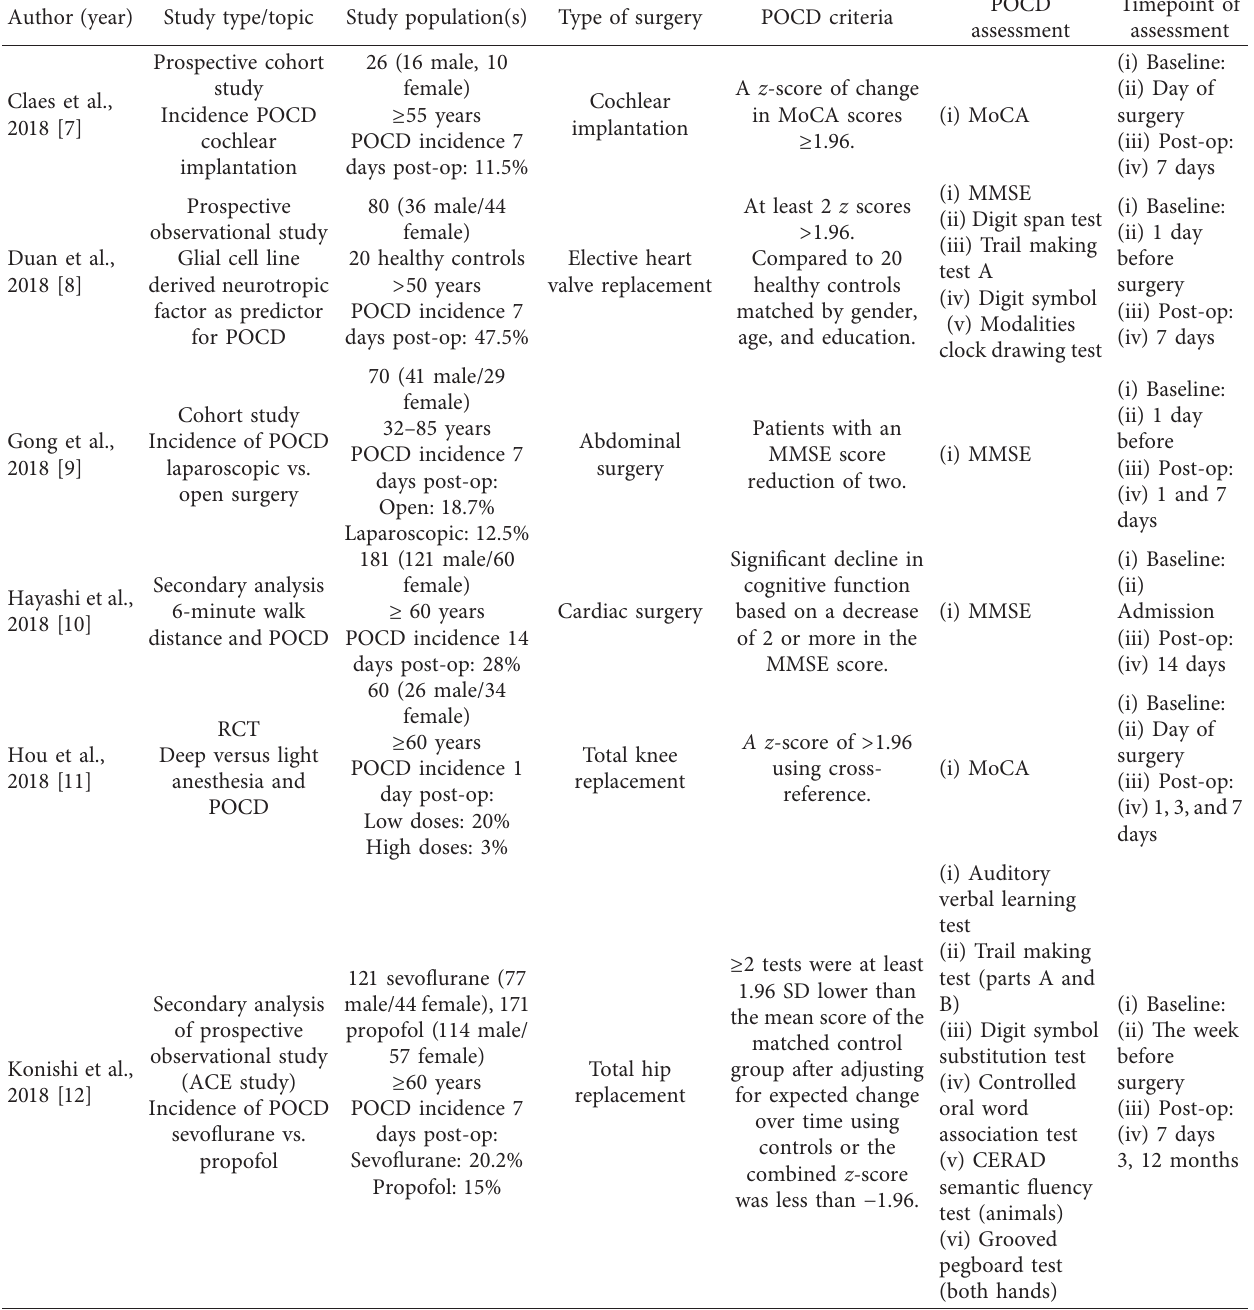
Table 1: Characteristics of studies reporting diagnostic criteria to define